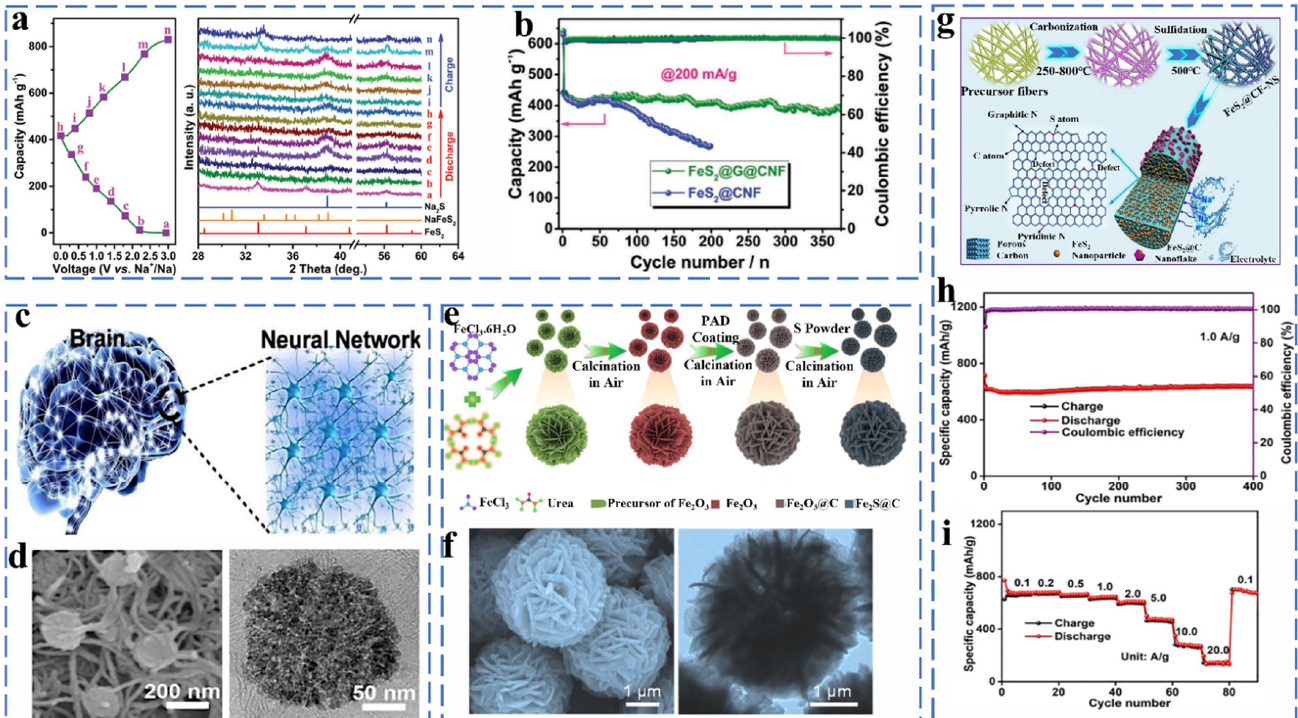
Figure 1. ( a ) The ex situ XRD patterns of FeS 2 @G@CNF as Na-ion battery anodes during the discharge and charge process, ( b ) discharge capacities at 200 mA g − 1 . Reprinted with permission from Ref. [18]. Copyright 2019, copyright Chen, C. ( c ) Schematic illustration of the FeS 2 /CNT neural network nanostructure composite (FeS 2 /CNT-NN), ( d ) SEM and TEM images. Reprinted with permission from Ref. [28]. Copyright 2018, copyright Chen, Y. ( e ) Representative illustration of the synthetic process of multi-layer architecture of FeS 2 @C hybrids, ( f ) SEM and TEM images. Reprinted with permission from Ref. [29]. Copyright 2019, copyright Wu, X. ( g ) Schematic illustration of the synthesis process of the FeS 2 @CF-NS, ( h ) cycling performance at current density of 1.0 A g − 1 , ( i ) Rate performance at different current densities. Reprinted with permission from Ref. [30]. Copyright 2021, copyright Shao, L.